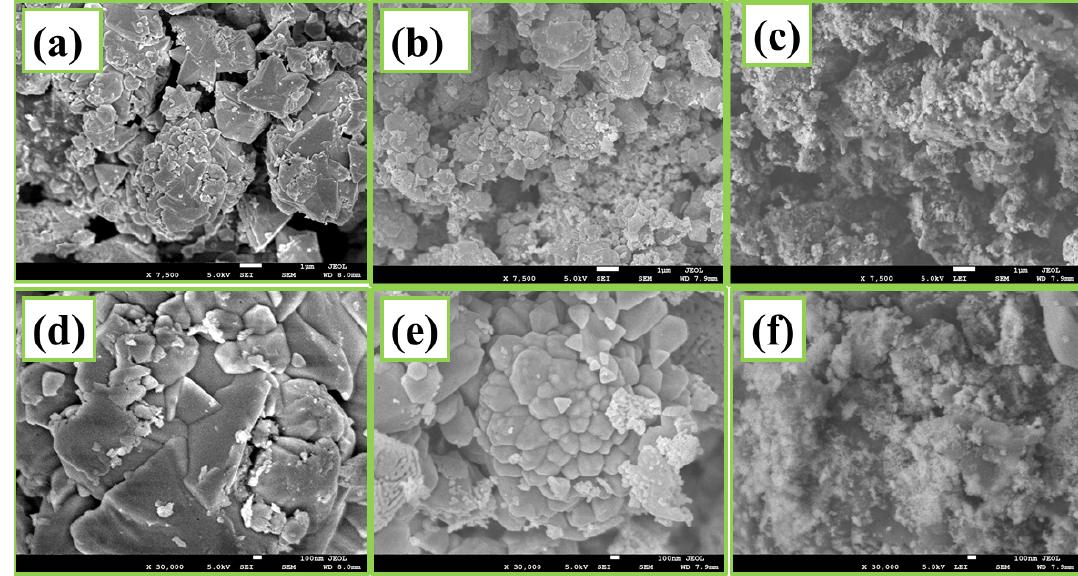
Figure 4. Low and high magnification SEM images of the Zn-U1 ( a , d ), Zn-U2 ( b , e ), and Zn-U3 ( c , f ) nanocomposites.